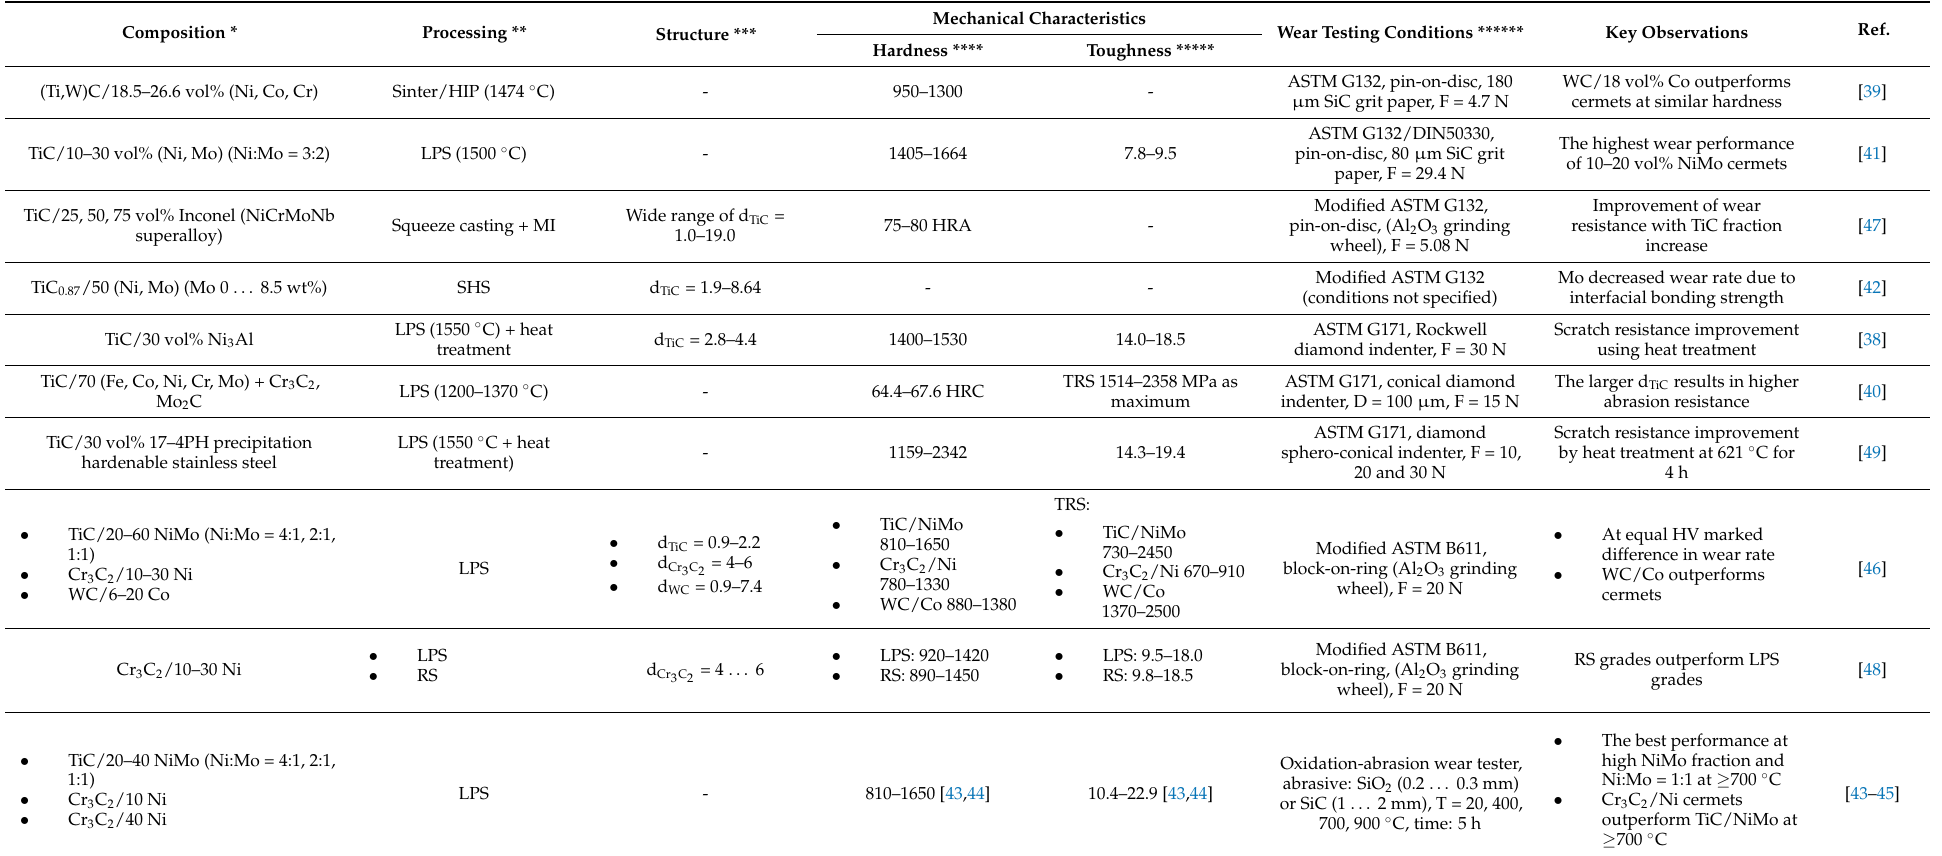
Table 1. Summary of composition, processing, structural and mechanical characteristics and two-body abrasive wear testing conditions of